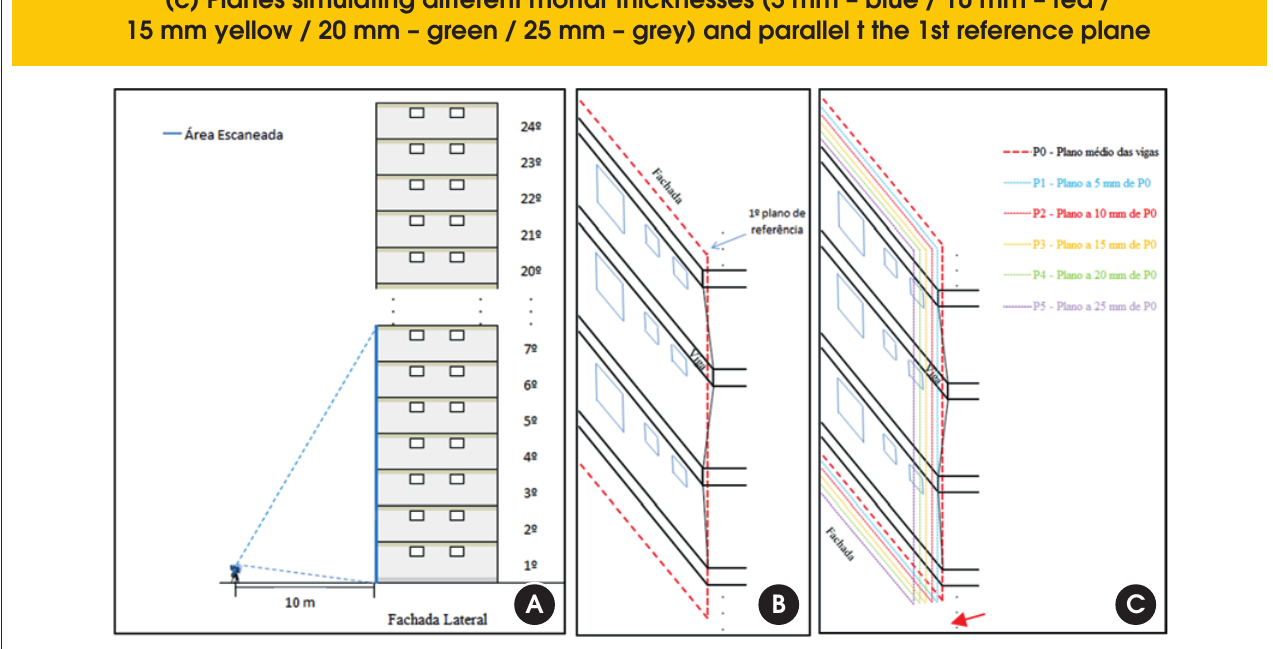
Figure 9 – (a) Distance of scanner in relation to the facade; (b) 1st reference plane; (c) Planes simulating different mortar thicknesses (5 mm – blue / 10 mm – red /